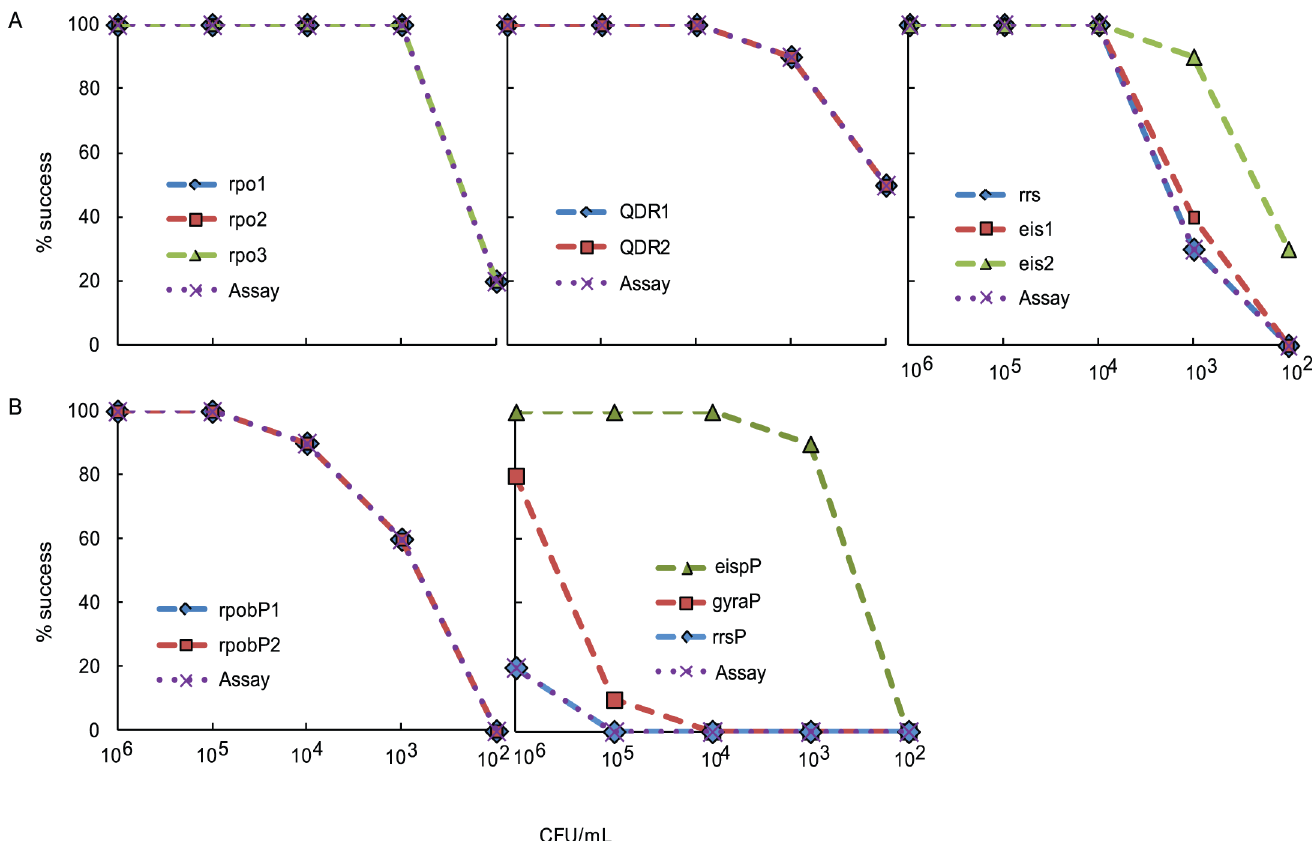
Fig 4. Limit of detection (LOD) of the individual SMB and DLP assays on sputum spiked with M . bovis BCG CFU. Both SMB and DLP assays were performed on DNA isolated from sputum spiked with a serial dilution of M . bovis BCG CFU as indicated. Assay success rates for individual probes and the entire assay over the dynamic range of spiked CFU/ml are shown. Panel (A) SMB probe and assay performance; Panel (B) DLP probe and assay